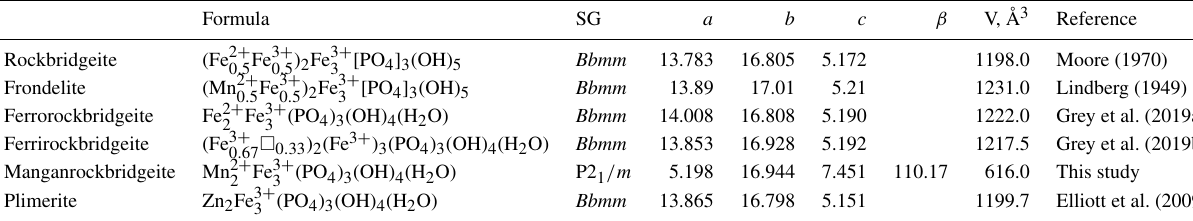
Table 7. Ideal formulae, A 2 B 3 (PO 4 ) 3 X 5 , and unit-cell parameters for rockbridgeite-group minerals. Formula